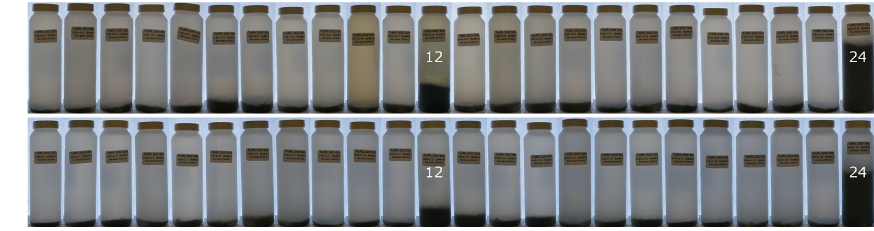
Figure 2. Sediment-trap bottles of the upper (1200m) and lower (3500m) traps at station M4 (12 ◦ N, 49 ◦ W).